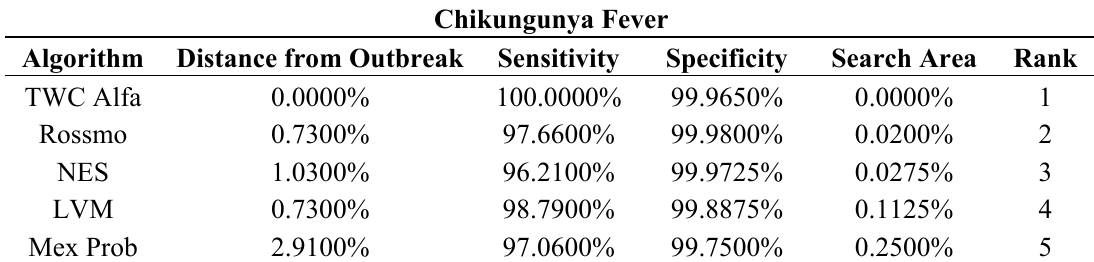
Table 2. Chikungunya fever results.